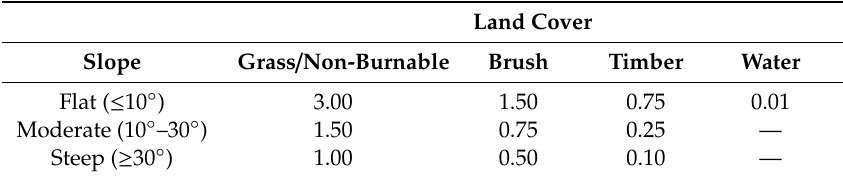
Table 2. Wildland Fire Decision Support System (WFDSS) travel rates based on slope and land cover, in miles per